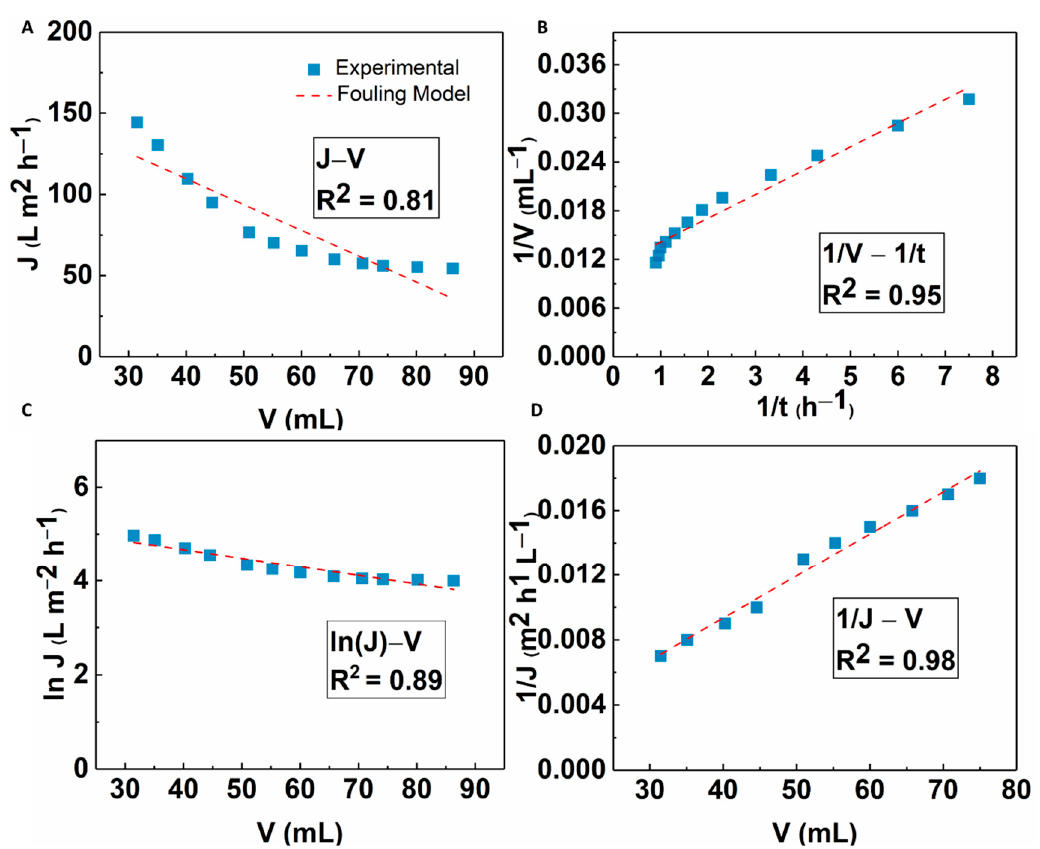
Figure 14. Fitting results of the flux decline analyzed by four fouling mechanism models: ( A ) com- plete blocking, ( B ) standard blocking, ( C ) intermediate blocking, and ( D ) cake filtration. blocking, ( B ) standard blocking, ( C ) intermediate blocking, and ( D ) cake